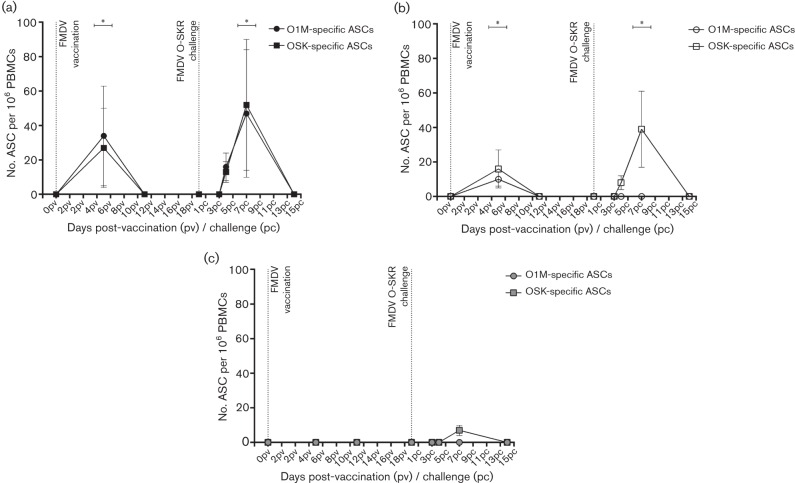
Kinetics of the FMDV-O-serotype-specific plasma-cell response in cattle post-vaccination and live-virus challenge. Kinetics of the O-serotype FMDV-specific plasma-cell response post-vaccination and intradermolingual live-FMDV-O-SKR-virus challenge (indicated by vertical dotted line). (a) FMDV O1-Manisa-vaccinated animals (O1M group, black symbols, n=5), (b) FMDV O-SKR-vaccinated animals (OSKR group, open symbols, n=5) and (c) non-vaccinated controls (NVC group, grey symbols, n=3). On all of the graphs, the FMDV O1-Manisa-specific ASCs are shown as circle symbols and FMDV-O-SKR-specific ASCs shown as square symbols. Results are expressed as the grouped mean of duplicate determinations from each calf±sd. Statistically significant time points, as compared with 0 dpc (P<0.05) are indicated with a * symbol.